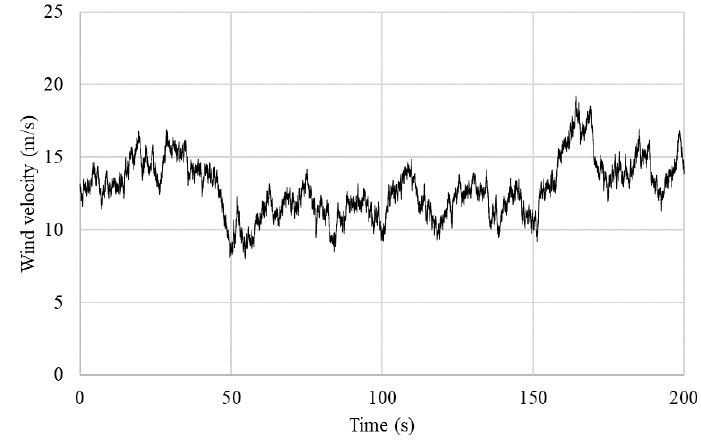
Figure 10. A wind velocity simulation. Table 1. Material and geometric properties of the jacket